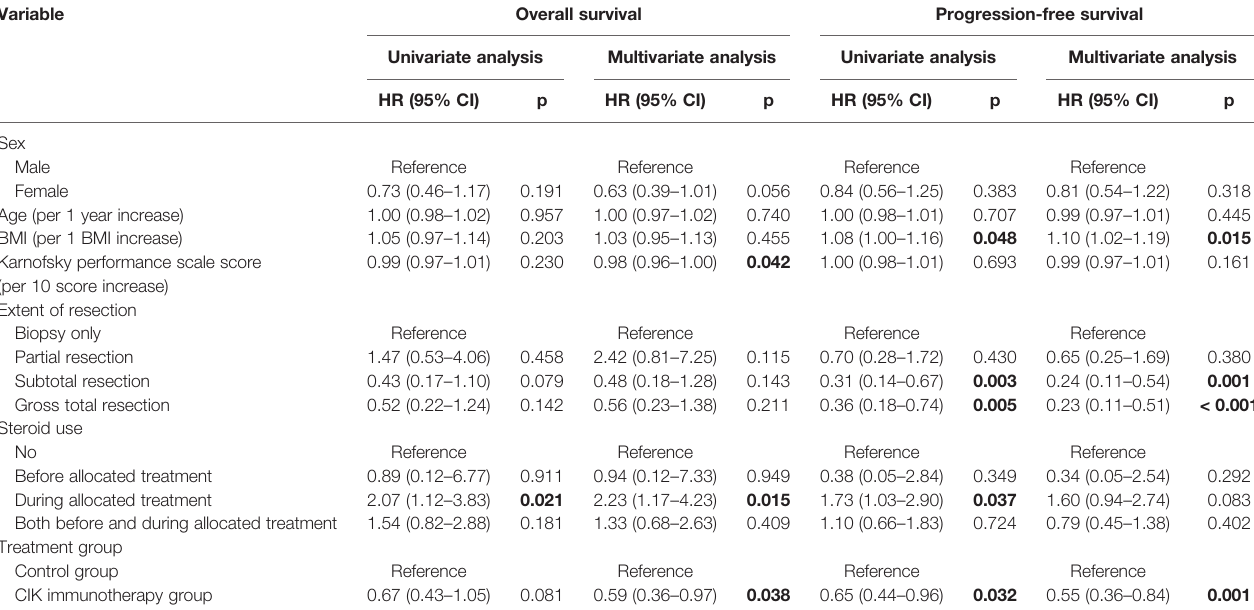
TABLE 2 | Overall survival and progression-free survival analyses according to the clinical parameters of patients with pure GBM in the modi fi ed ITT population. Variable